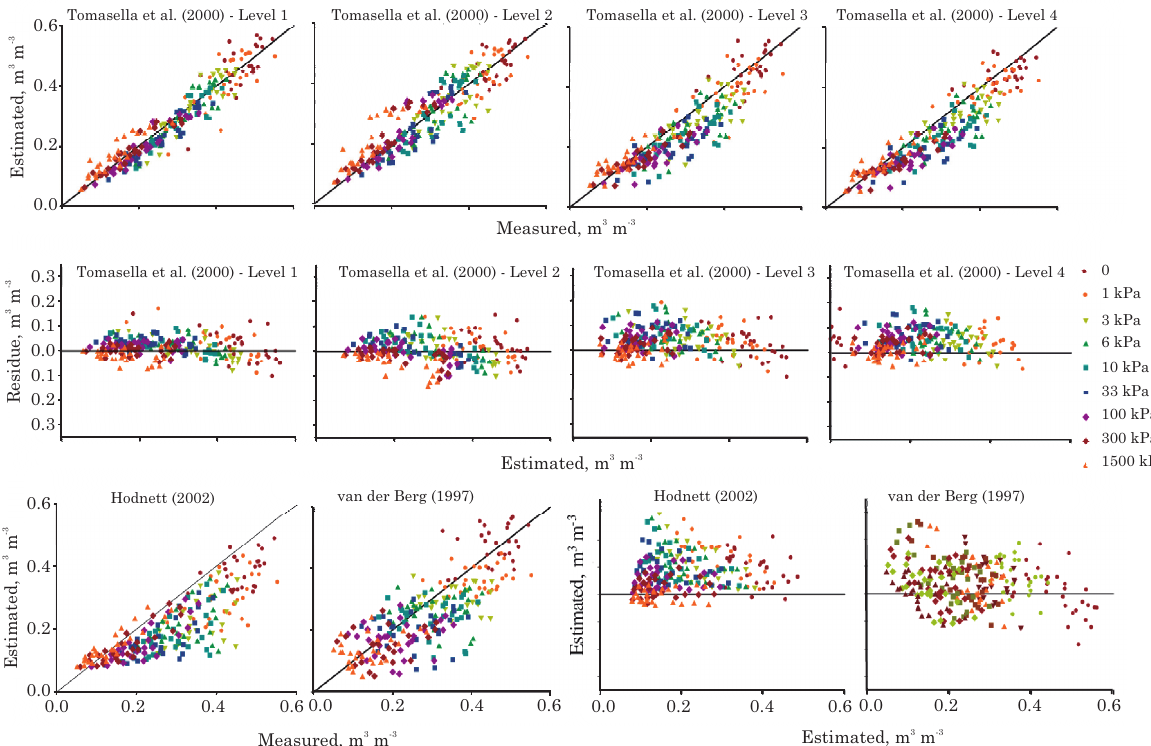
Figure 5. Measured vs estimated volumetric water content, and estimation residue for the parametric PTFs tested in the surface soil layer (0-5 cm) (n = 27).